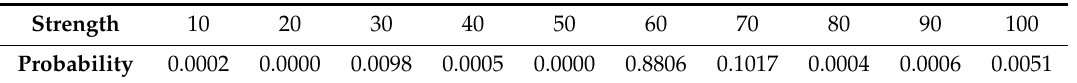
Table 1. Prediction result of a